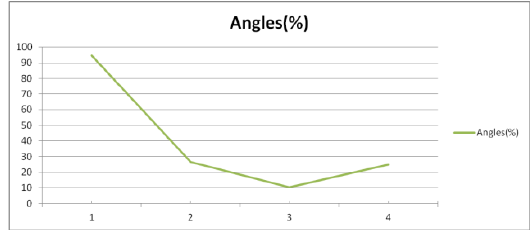
Figure 6: The percentages of the angles in the four phases of the simulation.